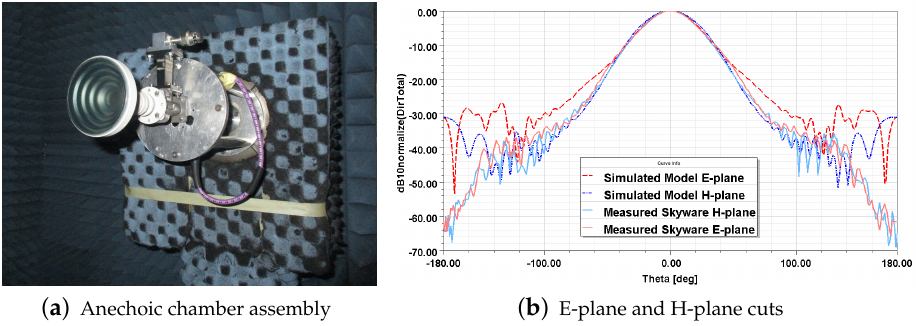
Figure 4. Skyware antenna assembly for characterization in anechoic chamber and its measured radiation pattern and the simulated one with the model created from measurements